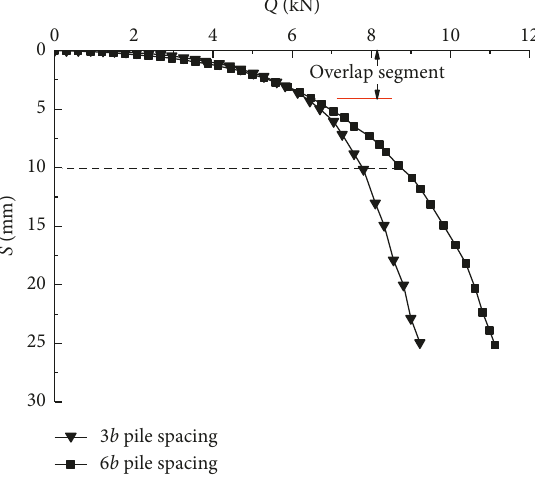
Figure 5: Load-settlement curves of pile